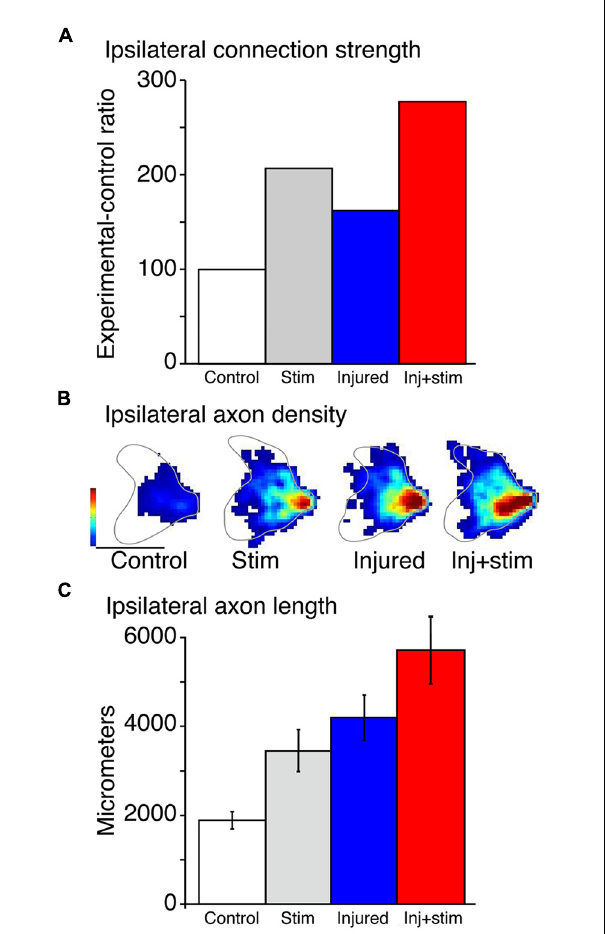
FIGURE 2 | Effects of stimulation, injury and their combination on the ipsilateral corticospinal tract. (A) Changes in the strength of ipsilateral corticospinal tract axons are assayed by the ratio of the thresholds to evoke an ipsilateral response and a contralateral response in each animal. Stimulation (Stim) and injury alone both show enhanced capacity to evoke ipsilateral motor responses, which is augmented further in the combined condition (Inj + stim). (B) The regional density of corticospinal tract axons within the ipsilateral spinal cord is displayed as heatmaps for each condition. Each heat map is an average of 4–6 animals per group.The color scales are the same for all animals. Calibrations: 500 μ m; Color